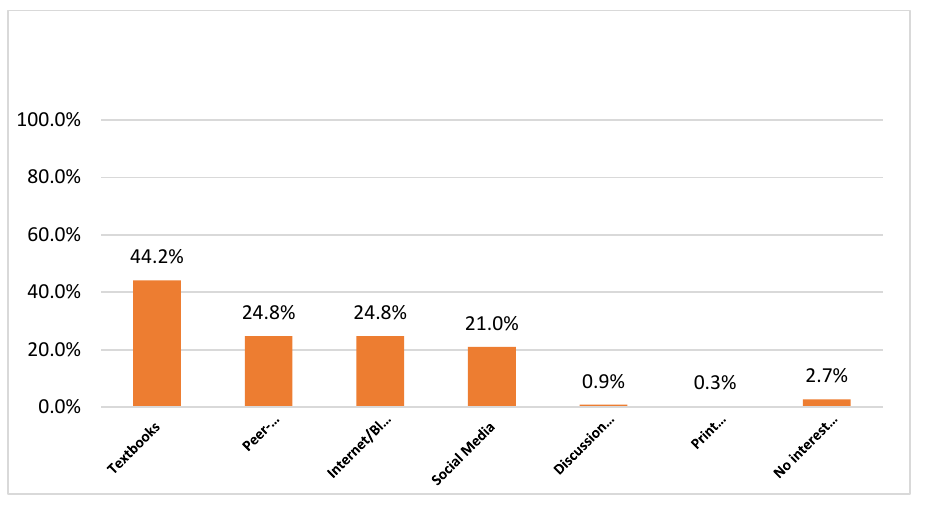
Figure 1. Respondents’ sources of information on oral sex.